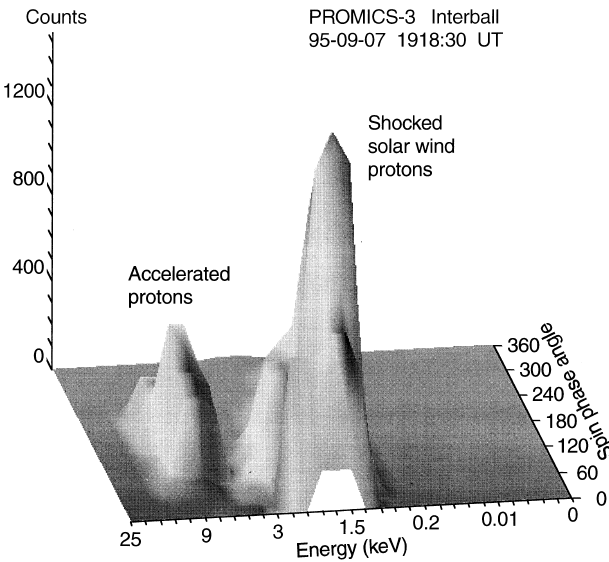
Fig. 9. Proton distribution measured in the dawnside mag- netosheath at about 30 R (cid:69) (GSM coordinates: ! 6.8, ! 23.2, 18.7) on 7 September 1995 at 1918:30 UT. There were two distinct popu- lations, shocked solar wind protons with a peak at about 1.5